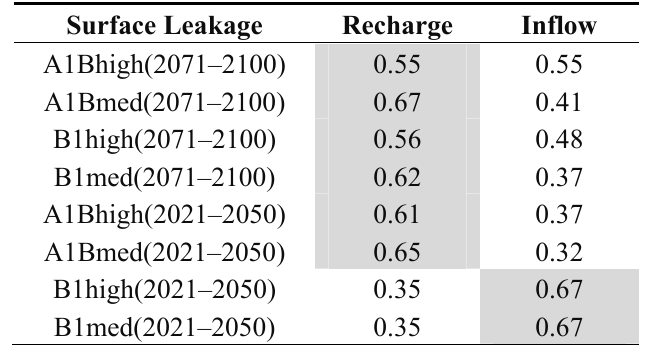
Table 3. Correlation coefficient (R 2 ) for the cross-plot between surface leakage and recharge, and surface leakage and inflow.